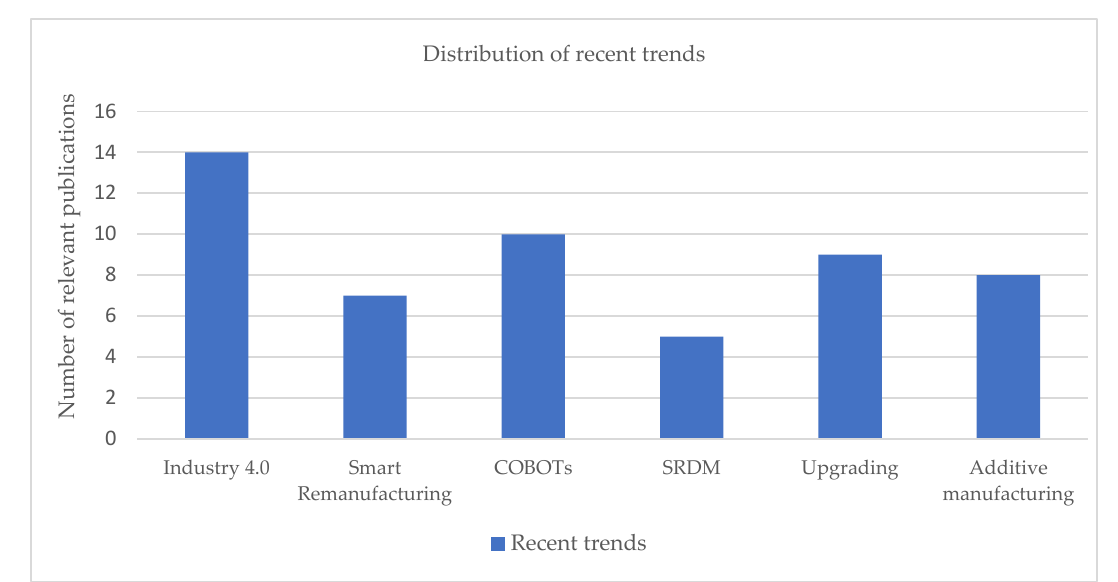
Figure 4. Distribution of recent trends.